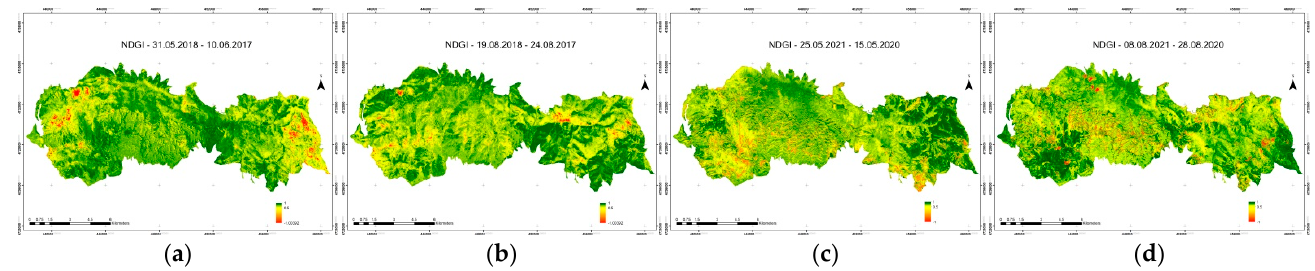
Figure 5. Maps with NDGI values for long-term periods ( a ) 10 June 2017–31 May 2018; ( b ) 24 August